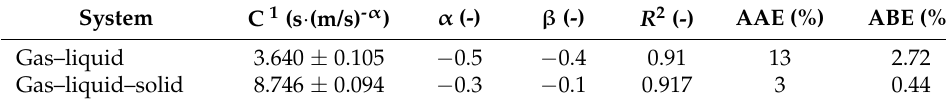
Table 12. Homogenization time t H : Evaluated parameters of correlation (6).